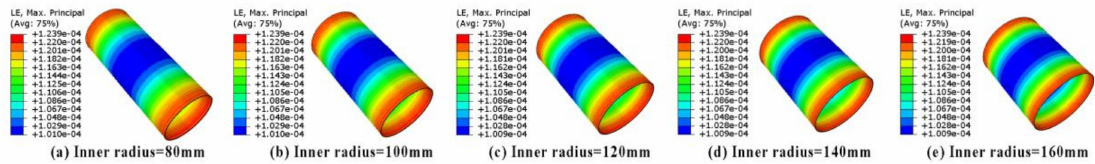
Figure 8. Influence of the inner radius on deformation of variable-stiffness composite